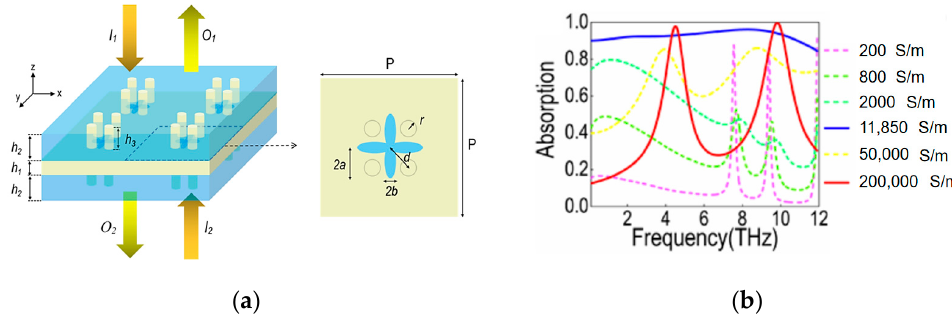
Figure 27. ( a ) The structure of a tunable coherent perfect absorber based on VO 2 metamaterial and ( b ) the absorption curve changing with VO 2 conductivity [65].